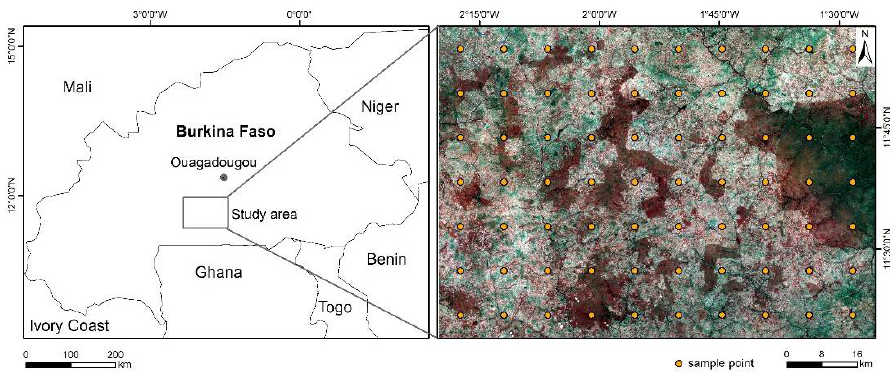
Figure 1. Study area and the distribution of random systematic sampling points based on Landsat 5 image acquired on 15 November 2014. Table 1. Frequency of all available Landsat images for the study area by year.